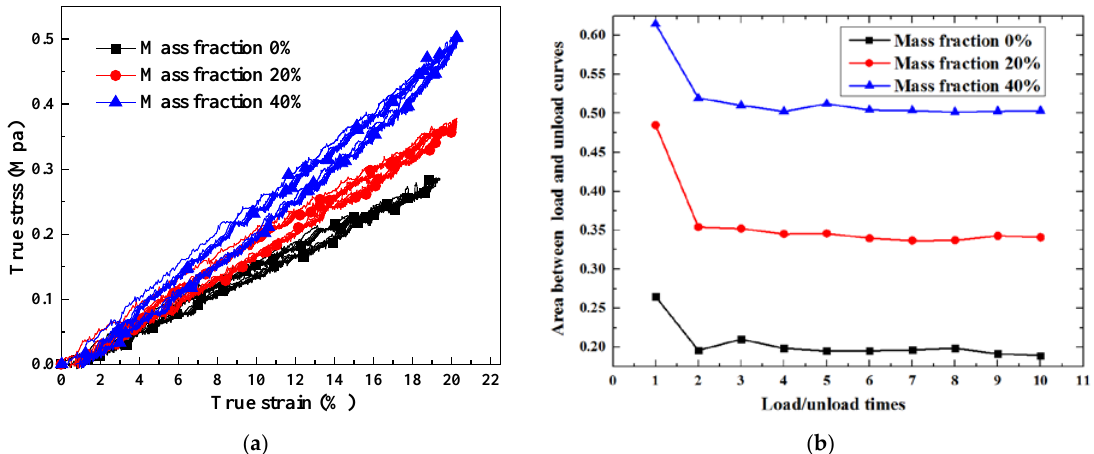
Figure 13. Load-unload test with different mass fractions of phosphor: ( a ) True strain versus true stress; ( b ) Areas between the load and unload curves versus load/unload times.